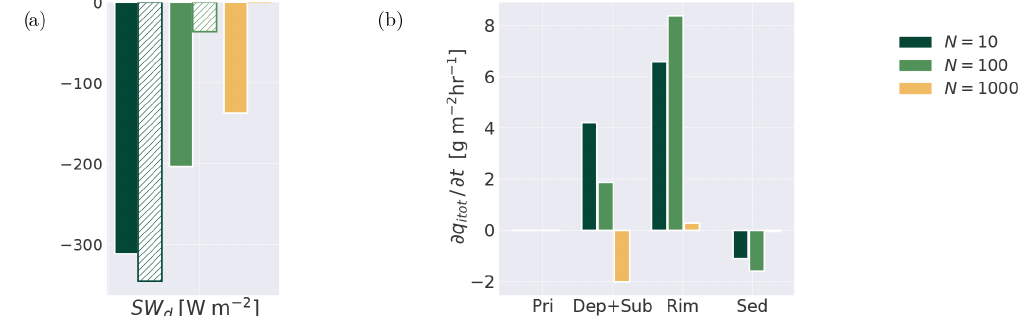
Figure 15. Bar plots of the effects of cloud processes. (a) The comparison of the shortwave downward flux estimated from the Twomey formula (shown as bars with the pattern) and the shortwave downward flux from the from the simulation output (shown as full colored bars); (b) vertically integrated tendencies in (total) ice water mass budget within the cloud layer: primary ice nucleation and freezing of cloud droplets (Pr i , significantly smaller than other tendencies), the combined effect of deposition and sublimation (Dep + Sub), riming of cloud droplets (Rim), and sedimentation (Sed). The time averaging covers the last 48h of the